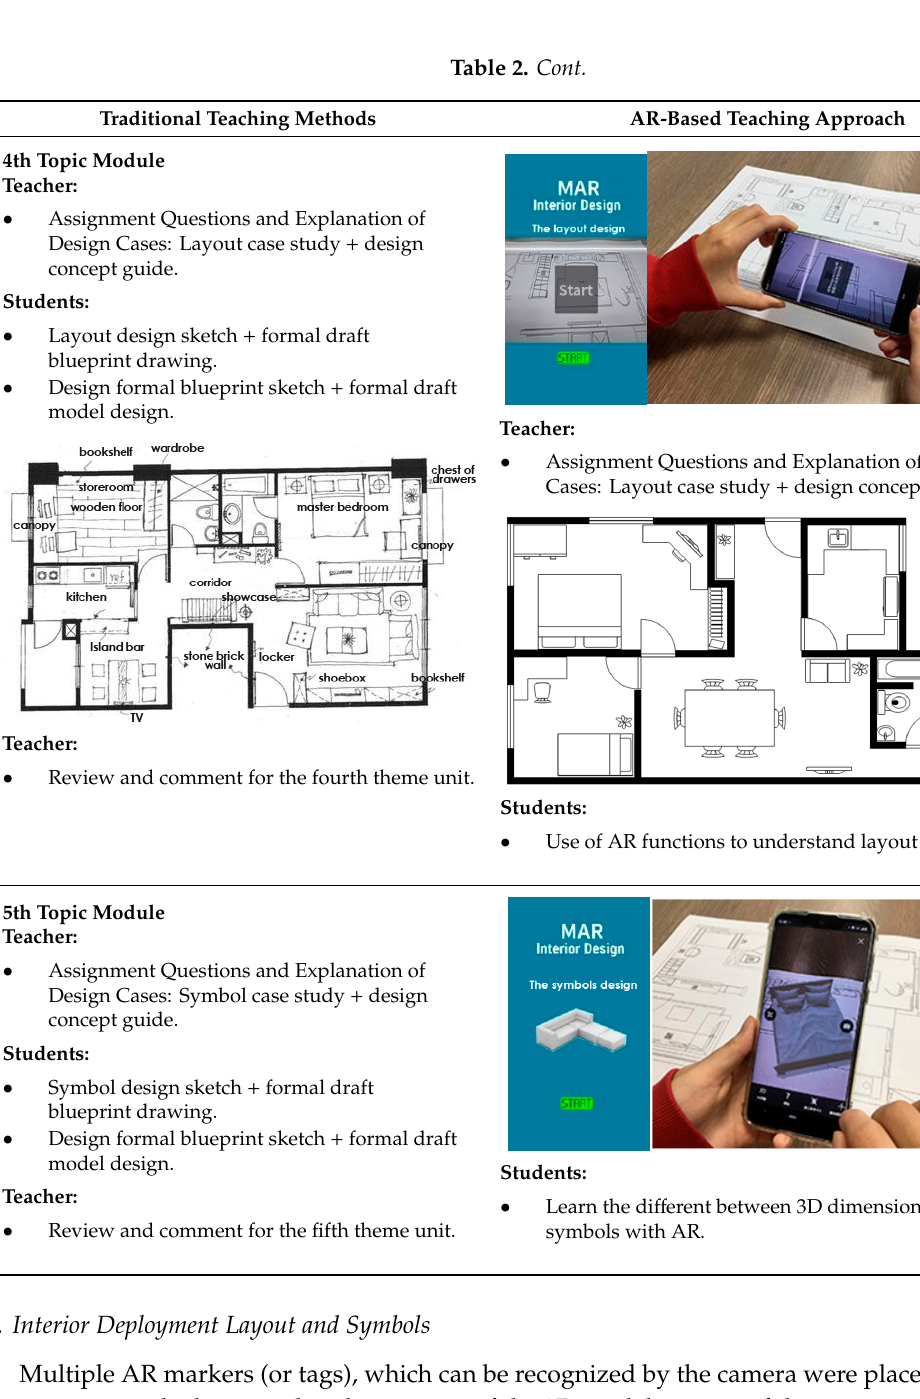
(b) Figure 3. ( a ) AR-based simulation of 2D interior design layout plans and integration of 3D images of interior design symbols; ( b ) Students can evaluate different design decisions by moving 3D objects in AR on their mobile phone screens.